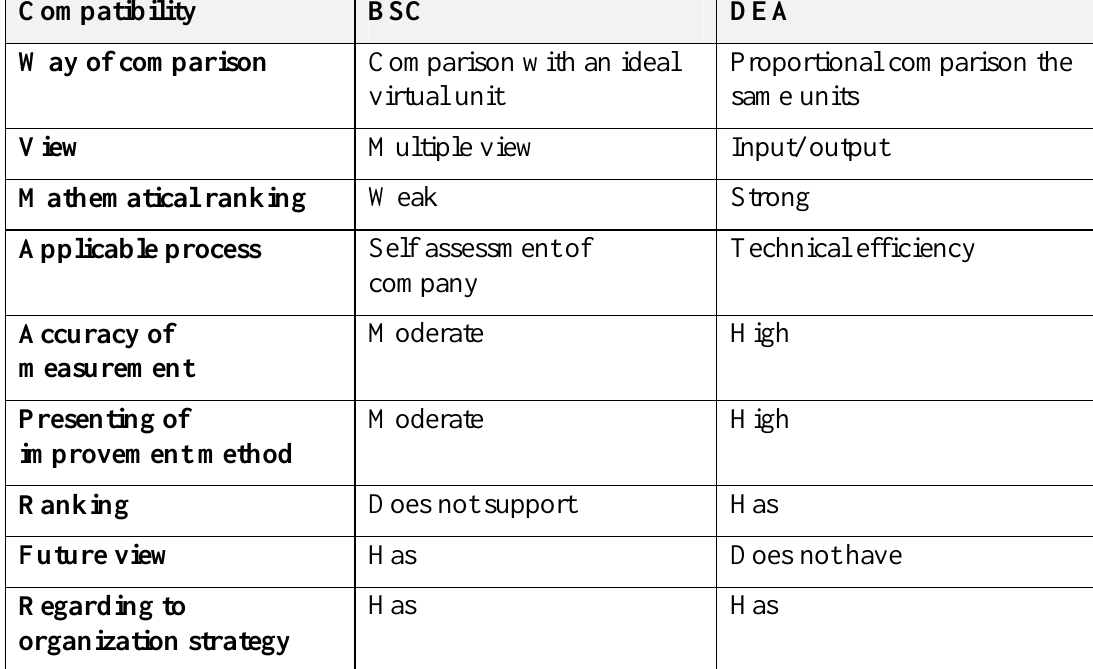
Table 1 – Proposed differences between DEA and BSC method (Aryanezhada, et al.,